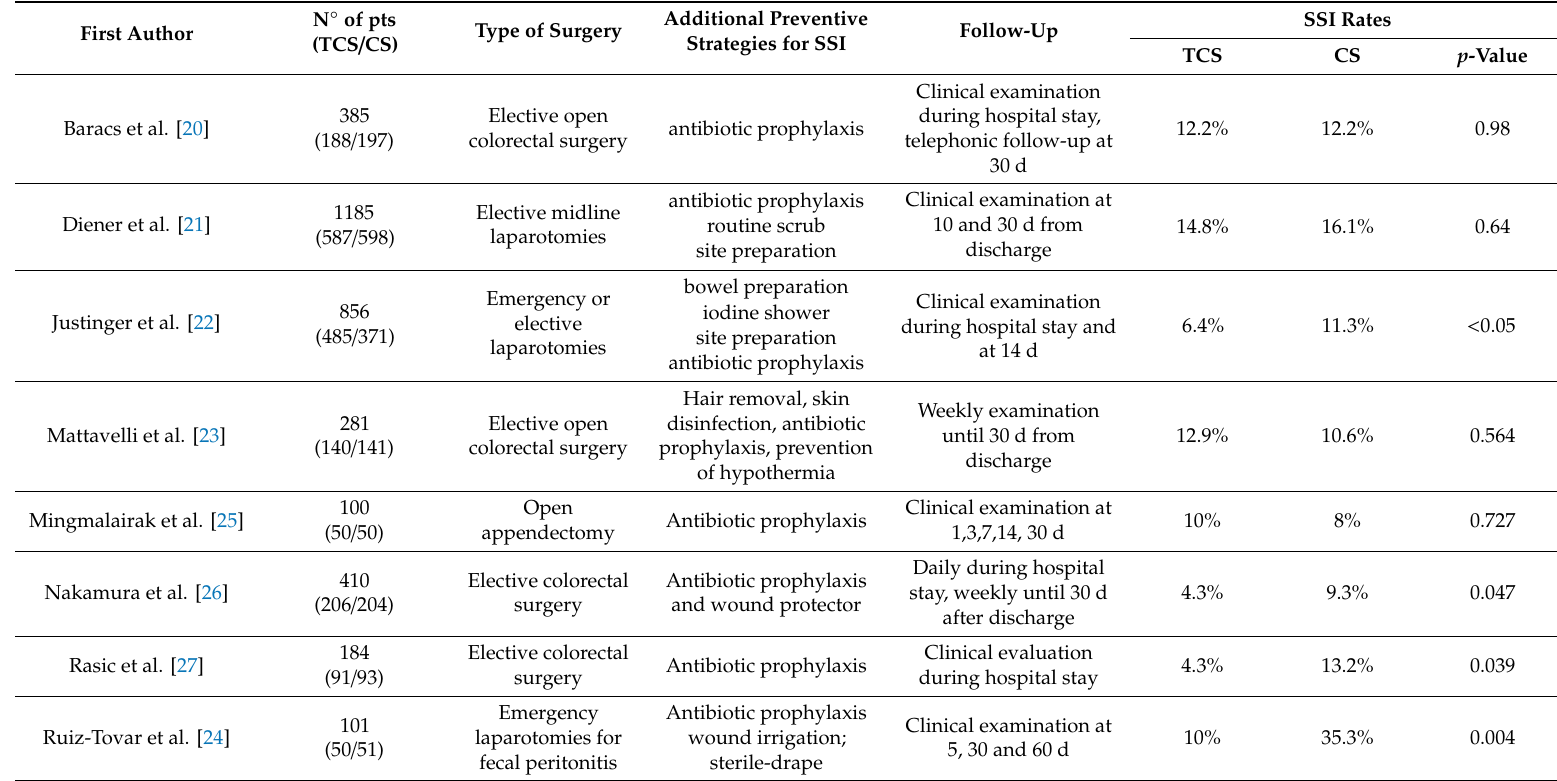
Table 3. Details of the randomized trials included in the Henriksen et al.